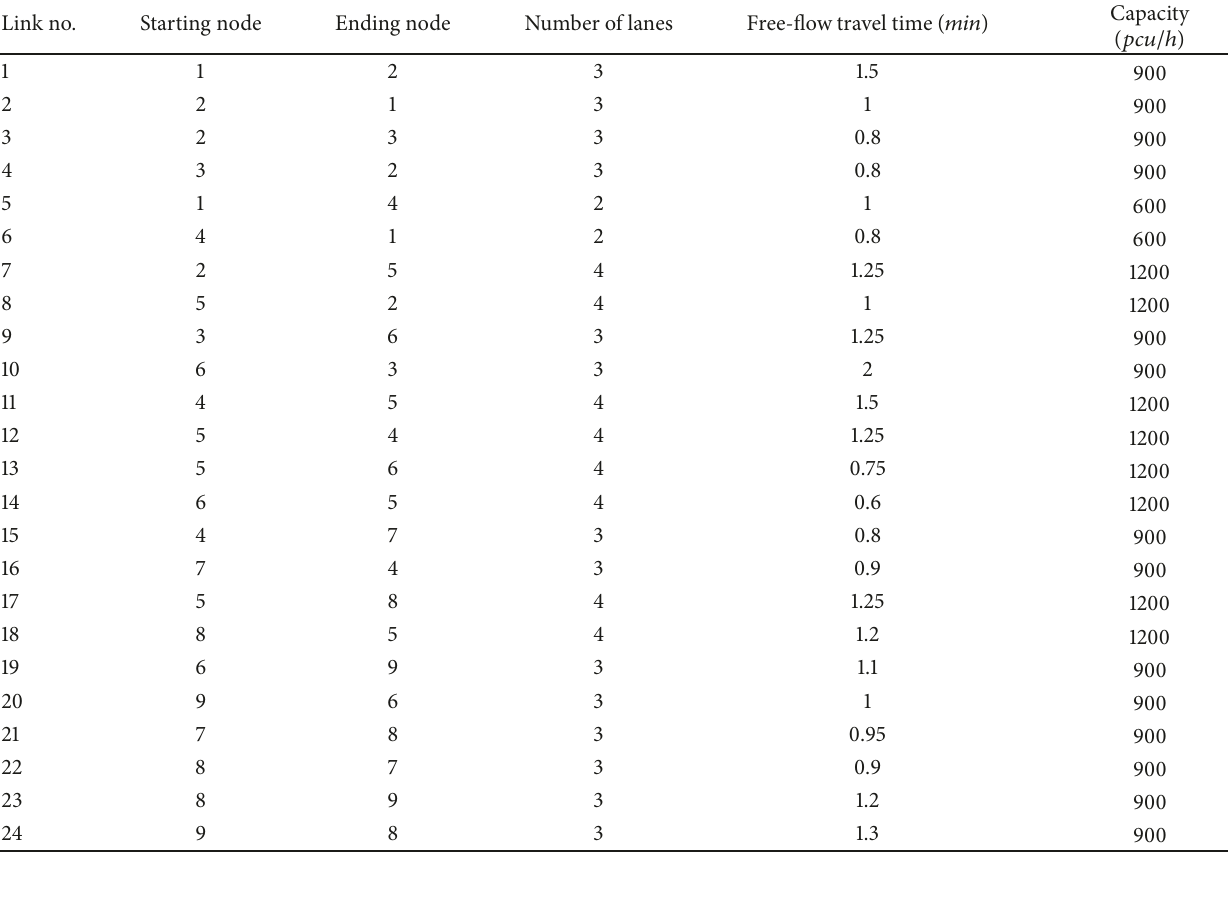
Table 1: Information of link properties.